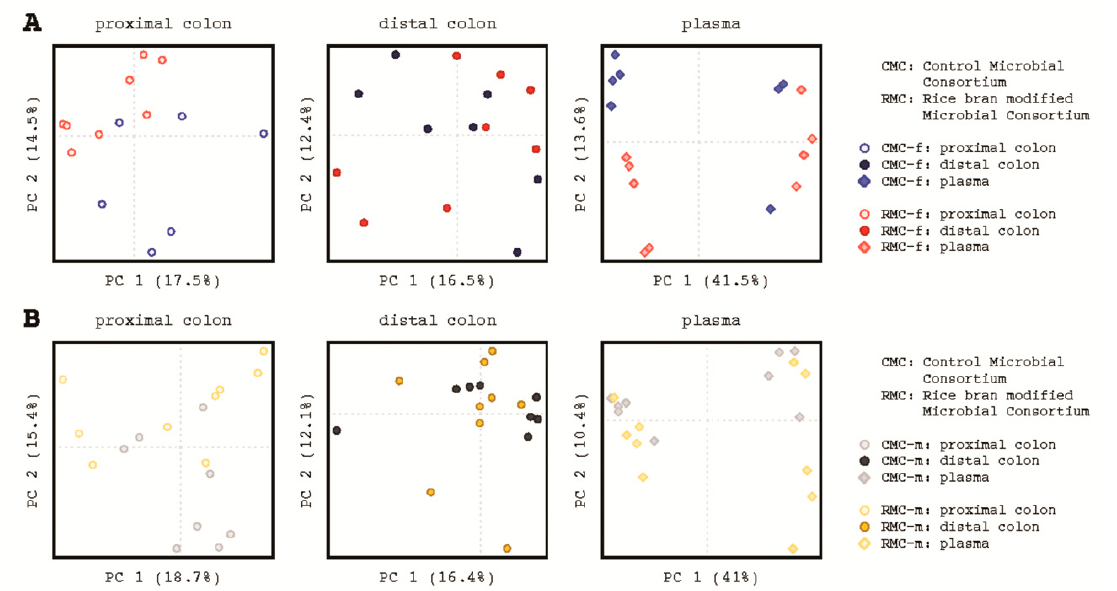
Figure 6. Principal Components Analysis of murine colon tissue (proximal and distal) and plasma metabolome. ( A ), Aitchi- son distances for proximal colon tissue (left), distal colon tissue (middle), and plasma (right) from mice colonized with consortia derived from the human female ( B ), Aitchison distances for proximal colon tissue (left), distal colon tissue (middle), and plasma (right) from mice colonized with consortia derived from the human males. Shapes distinguish murine sample type and colors denote male or female donor control or rice bran group.